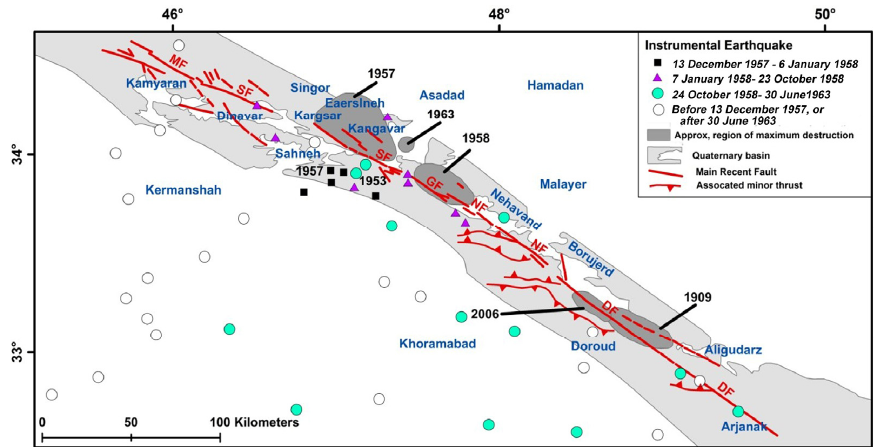
Figure 3. Seismicity and structure of the Zagros Main Recent Fault (MRF). The most recent and active structure (MRF) with its main segments is shown on the map. Five main segments of the MRF are DF, Doroud Fault; NF, Nahavand Fault; GF, Garun Fault; SF, Sahneh Fault; and MF, Morvarid